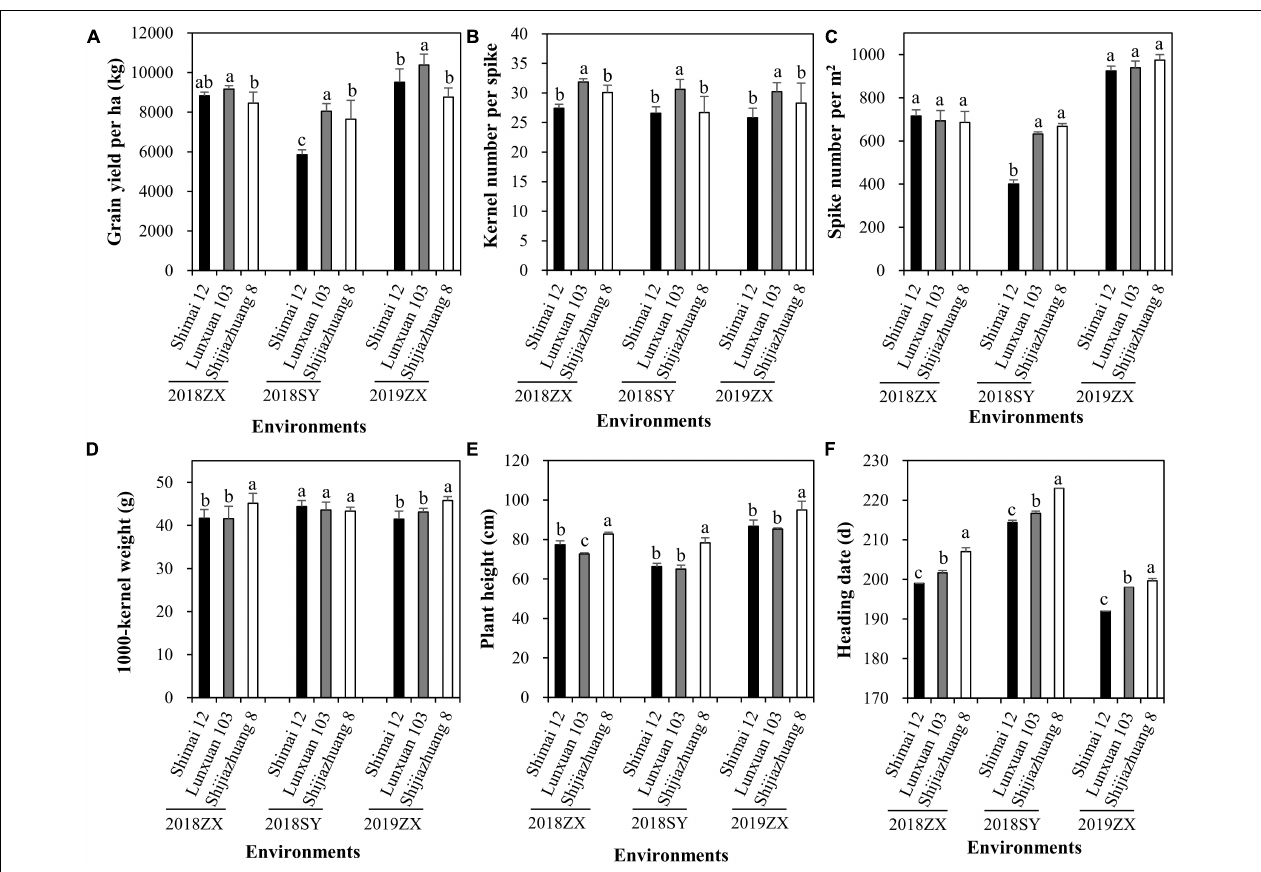
FIGURE 6 | Comparison of grain yield per ha (A) , kernel number per spike (B) , spike number/m 2 (C) , 1000-kernel weight (D) , plant height (E) , and heading date (F) among wheat cultivar Lunxuan 103 and its parents at the three environments. Multiple comparisons were performed using the least significant difference (LSD) test and different letters above the error bars indicate significant differences among cultivars in a single environment at P <